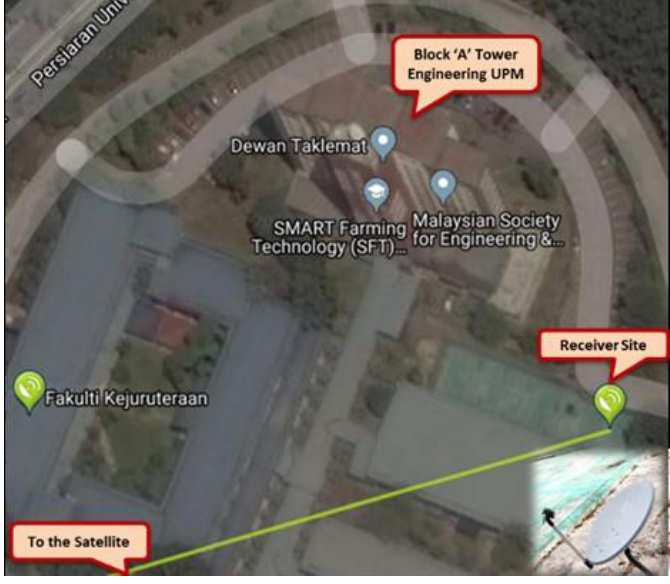
Figure 4. Aerial view of the experimental site, the ground station located in a futsal court with a clear canopy.